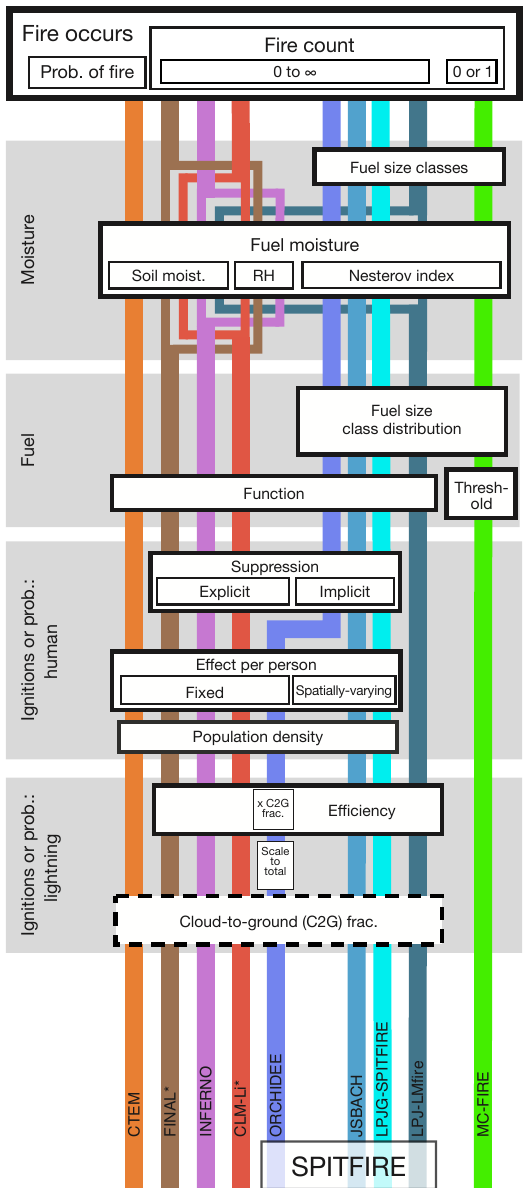
Figure 3. Modeled processes leading to fire starts for the participating models. Beginning at the bottom, models explicitly simulate processes that their colored line passes through, with the end result being the calculation of fire count (which in most models can be any nonnegative number, but in MC-FIRE can only be zero or one) or probability of fire. (LPJ-GUESS-SIMFIRE-BLAZE and LPJ-GUESS-GlobFIRM are not included here because they do not calculate fire count or probability.) Fire occurrence depends on three factors: ignitions, fuel availability, and fuel moisture. Lightning ignition count or probability are functions of the flash rate multiplied in some models by the “cloud-to-ground fraction” (which the input data for FireMIP already includes and is thus not calculated here; dashed box) and/or by an “Efficiency” term describing what fraction of cloud-to-ground strikes actually serve as potential ignitions. (ORCHIDEE-SPITFIRE scales cloud-to-ground flash rate to total flash rate, then multiplies by a coefficient representing both cloud-to-ground fraction and ignition efficiency.) Human ignition count or probability are influenced by an “effect per person” parameter, which can either be “fixed” globally or “spatially varying.” Population density can also contribute to “suppression.” Suppression as a function of population density can be either “explicit” (i.e., calculated by a specific function) or “implicit” (i.e., included in the initial calculation of ignitions/probability). Fuel load affects fire occurrence either as a simple “threshold” or by the use of some more complex “function” such as a logistic curve. Some models use several “fuel size classes,” which can be important for both fuel loading and moisture